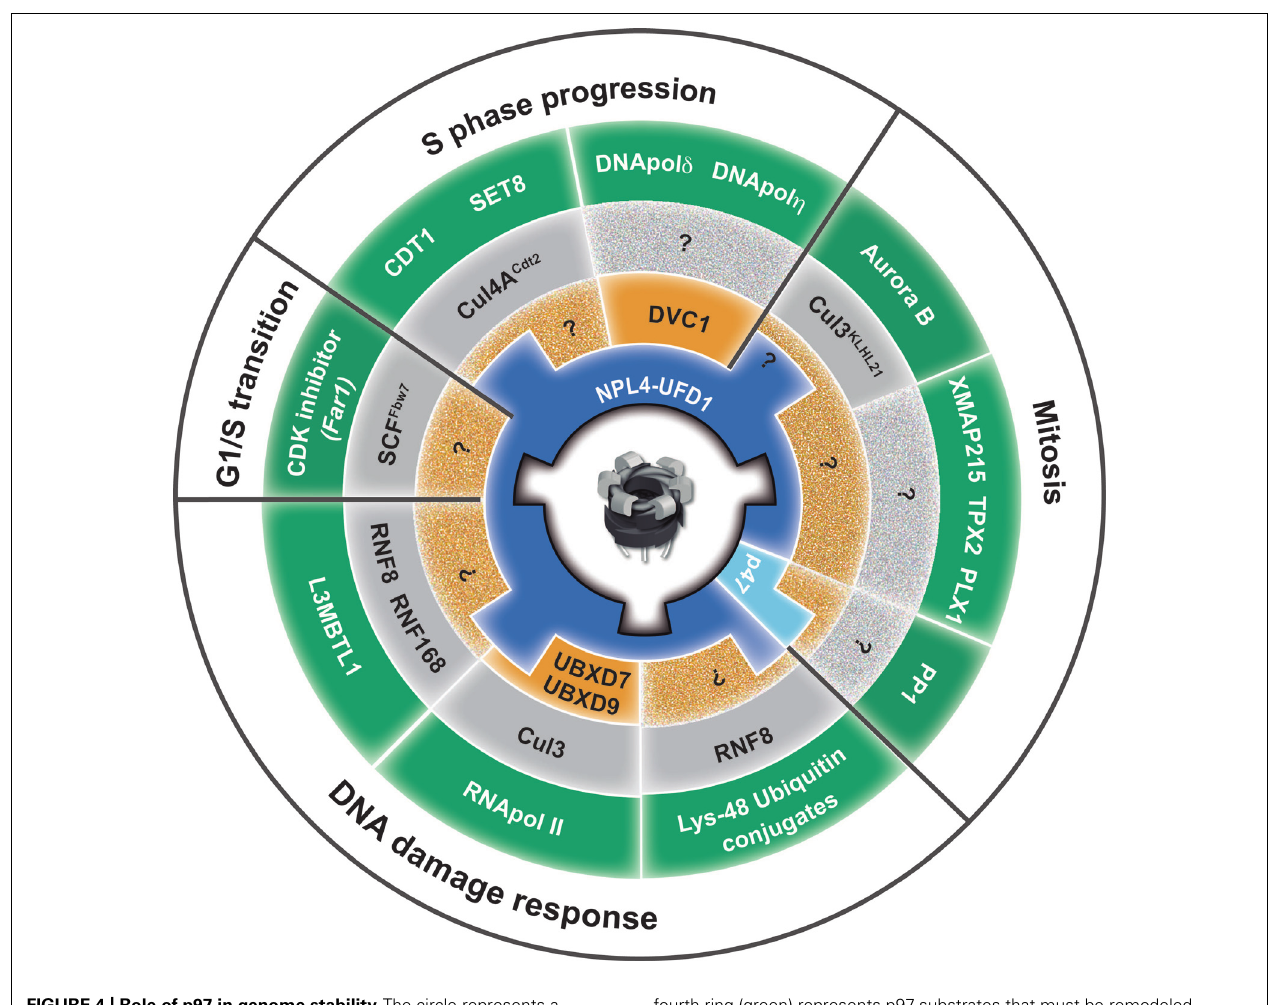
fourth ring (green) represents p97-substrates that must be remodeled (extracted) by p97 to avoid PICHROS and prevent genome instability. The fifth ring (white) represents different cellular processes in which p97 plays an essential role for maintenance of genome stability. PP1, protein phosphates 1/Glc7 in yeast; CDK inhibitor, cyclin-dependent kinase inhibitor Far1p in yeast; L3MBTL1, polycomb protein that contains malignant brain tumor (MBT) domain; CDT1, chromatin licensing and DNA replication factor 1; SET8, histone methyltransferase; XMAP215, processive microtubule polymerase;TPX2, microtubule associated protein; PLX1, polo-like kinase; DNA pol δ and η DNA polymerases delta and